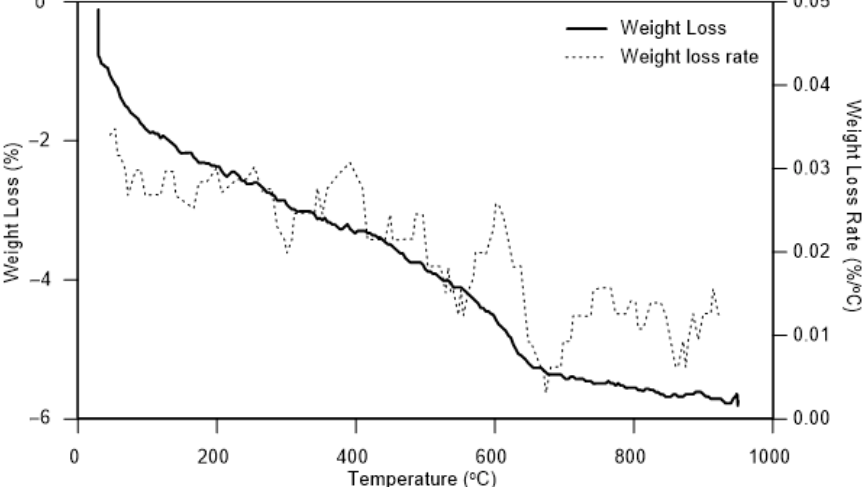
Figure 4. Thermo-gravimetric analysis of the investigated expansive clay.